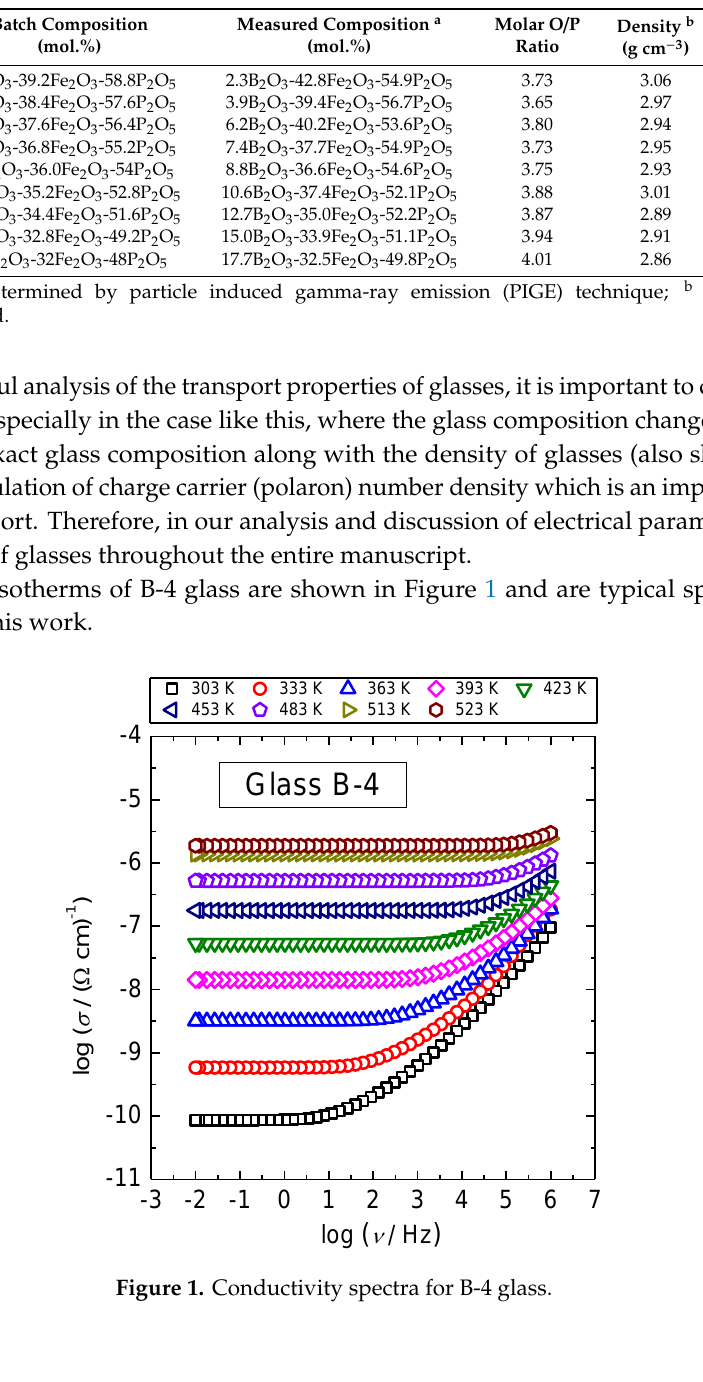
Table 1. Nominal batch and measured compositions (in mol.%) for studied x B 2 O 3 –(100− x )[40Fe 2 O 3 – 60P 2 O 5 ] glasses.